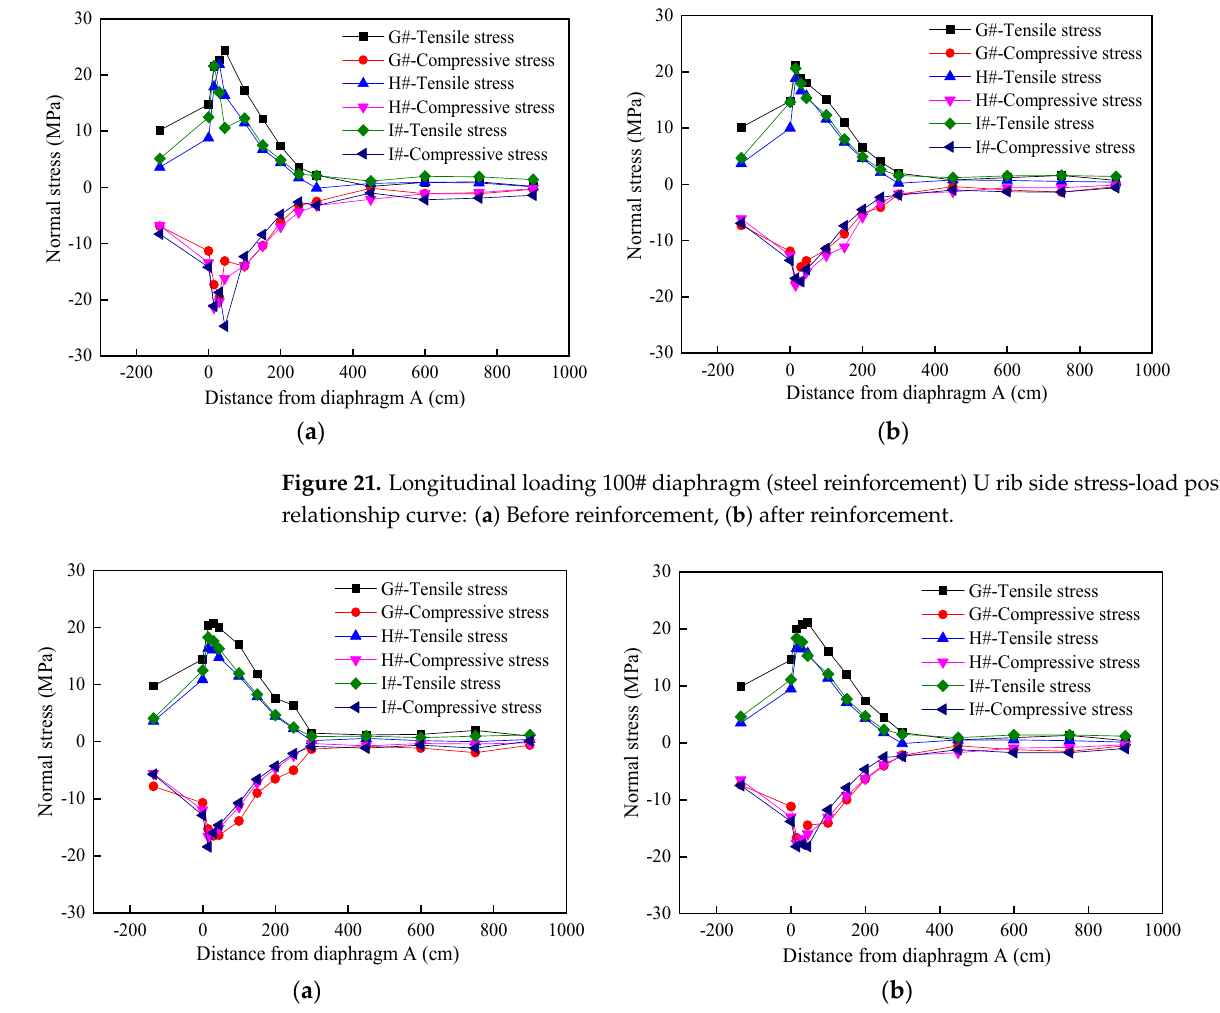
Figure 22. Longitudinal loading 105# diaphragm (notch optimization) U rib side stress-load position relationship curve: ( a ) Before optimization, ( b ) after optimization.